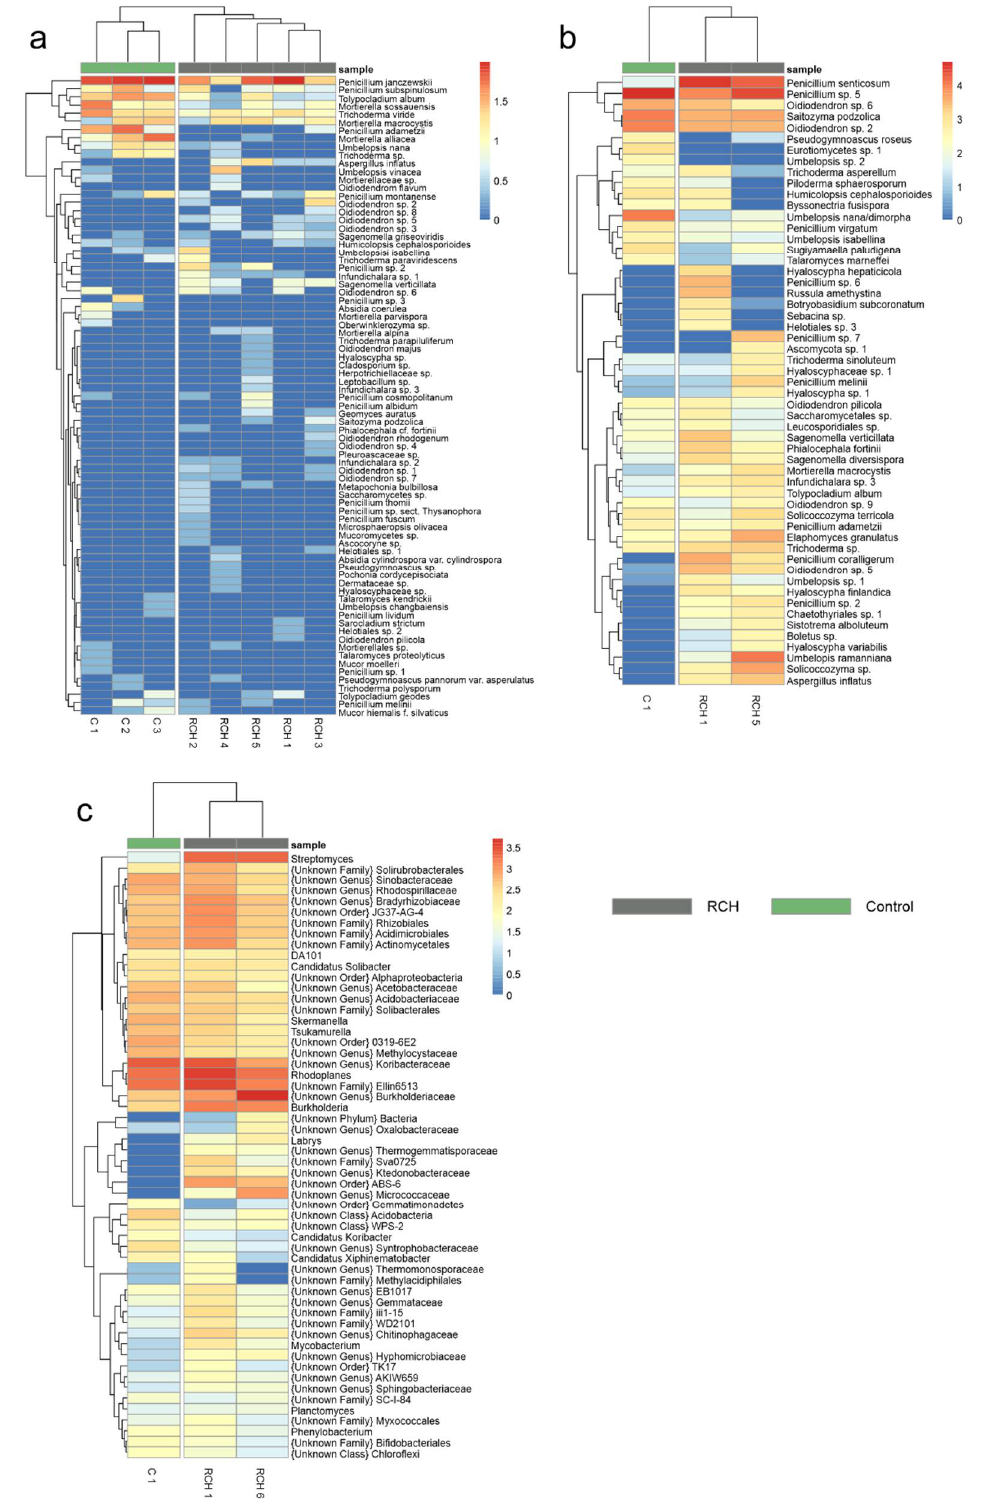
Figure 7. Heatmaps constructed based on log10 + 1 transformed abundance data on the occurrence of culturable fungi ( a ) and on the most frequent fungal species ( b ) and bacterial genera ( c ) generated in Illumina metabarcoding analysis. Minimum number of reads for ITS sequences was 350 and for 16S sequences it was 80. Please note consistent clustering of RCH samples (gray) against the control sample (green) in all three datasets.